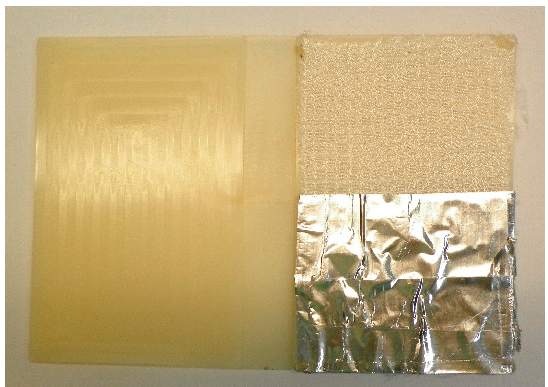
Figure 7. Prototype part for the manufacturing of the peeling test sample.